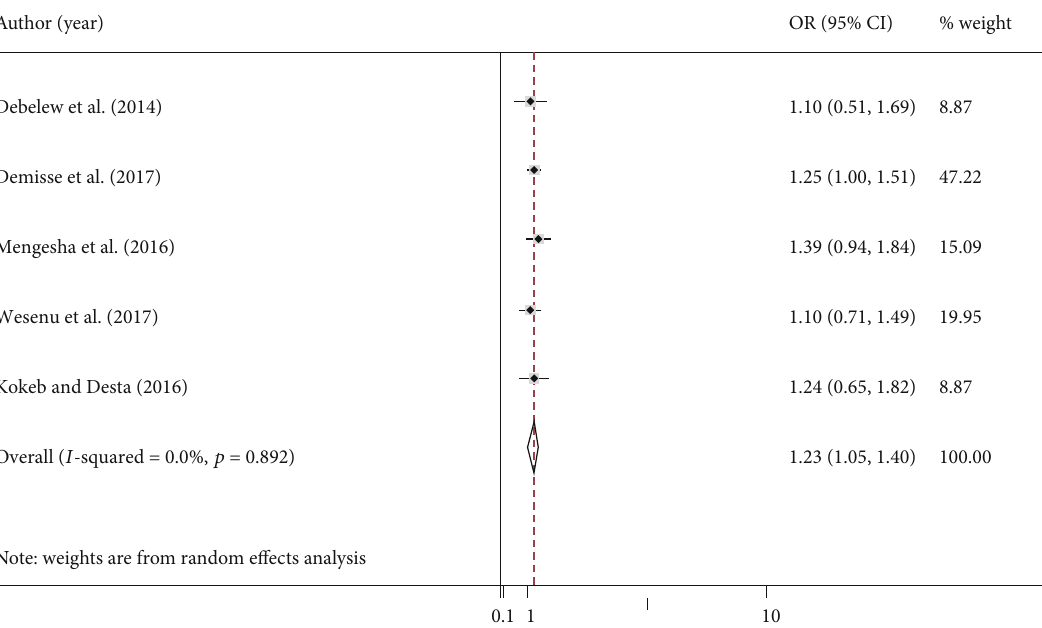
Figure 7: Pooled odds ratio of the association between neonatal sepsis and neonatal